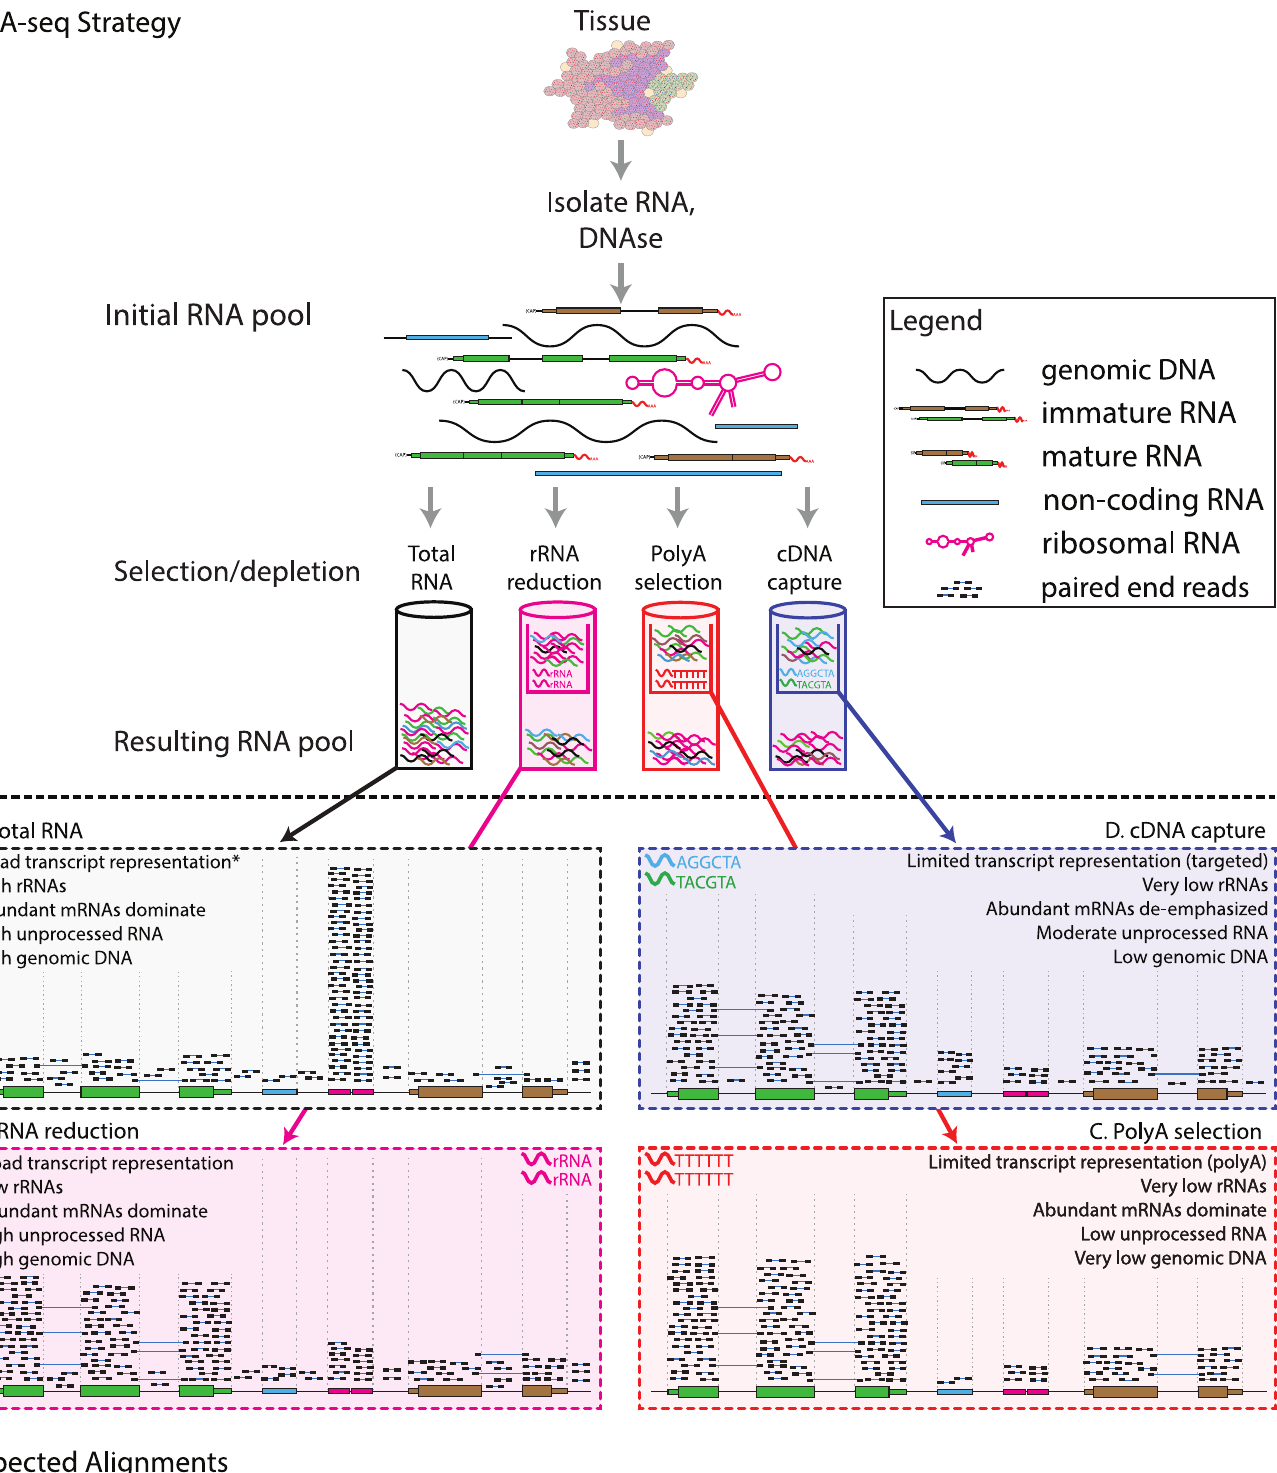
Fig 4. RNA-seq library enrichment strategies that influence interpretation and analysis. RNA-seq library construction protocols differ widely, and these differences have significant consequences for data interpretation and analysis. The figure above illustrates representative alignment results for either total RNA or one of three commonly used enrichment strategies at a hypothetical genomic locus with very highly expressed ribosomal RNA (pink), highly expressed protein coding (green), lowly expressed protein coding (brown) and lowly expressed noncoding RNA (blue) genes. (A) If total RNA is sequenced